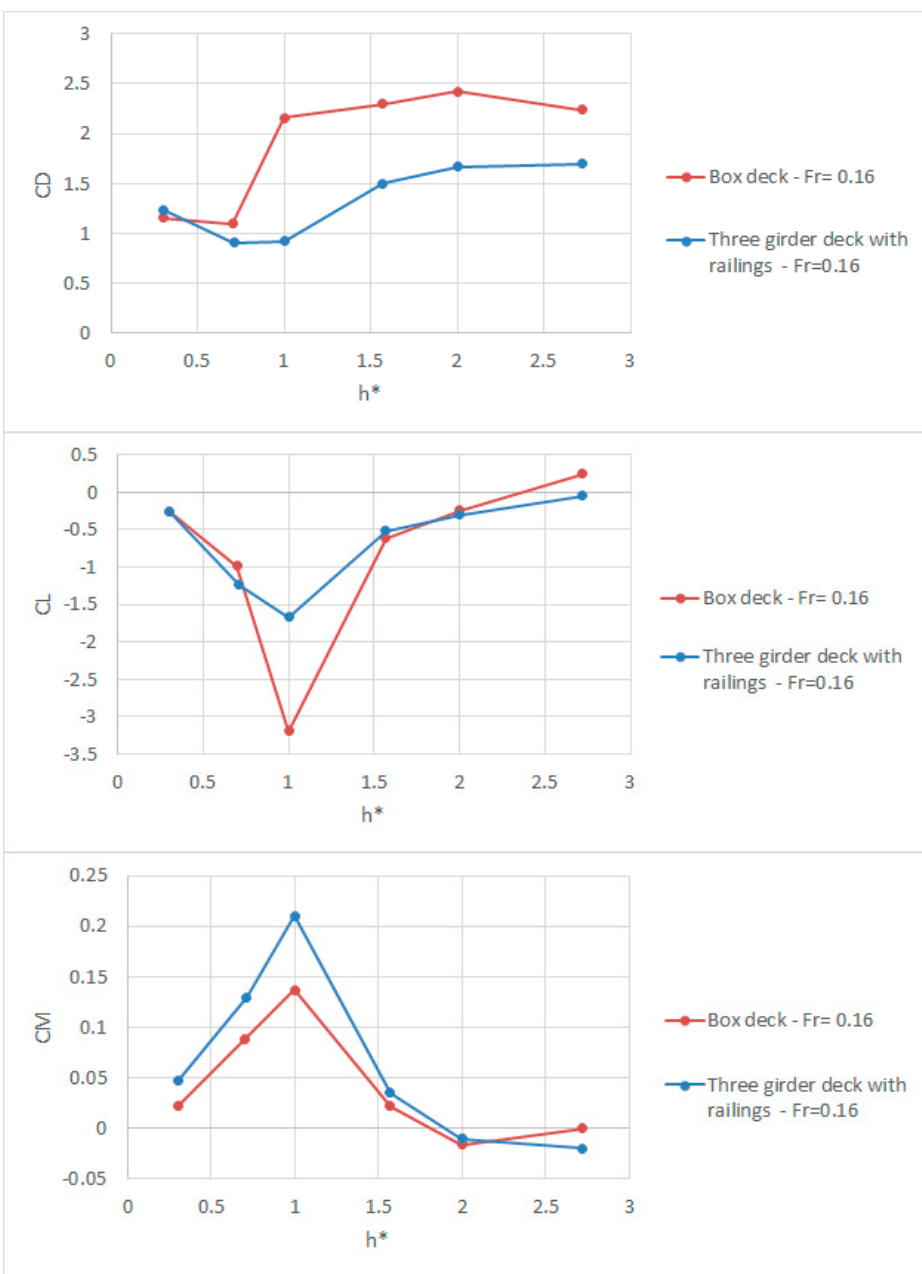
Figure 29. Dimensions of three girder deck in mm.